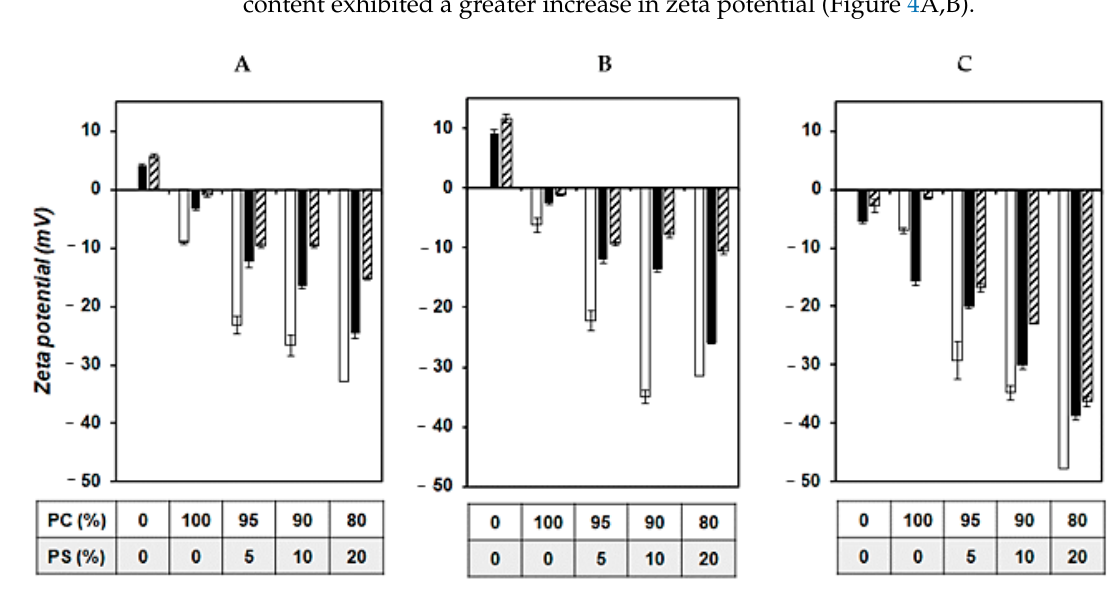
Figure 4. Zeta potential of liposomes composed of different PC/PS ratios in the presence or absence of NOTA-CAPs in a 10 mM HEPES buffer (pH 7.4). Liposomes were treated with 0, 10, or 20 µ M of NOTA-KV6 ( A ), NOTA-RV6 ( B ), or NOTA-HV6 ( C ) for 1 h. Values are means ± SEM; n = 3.